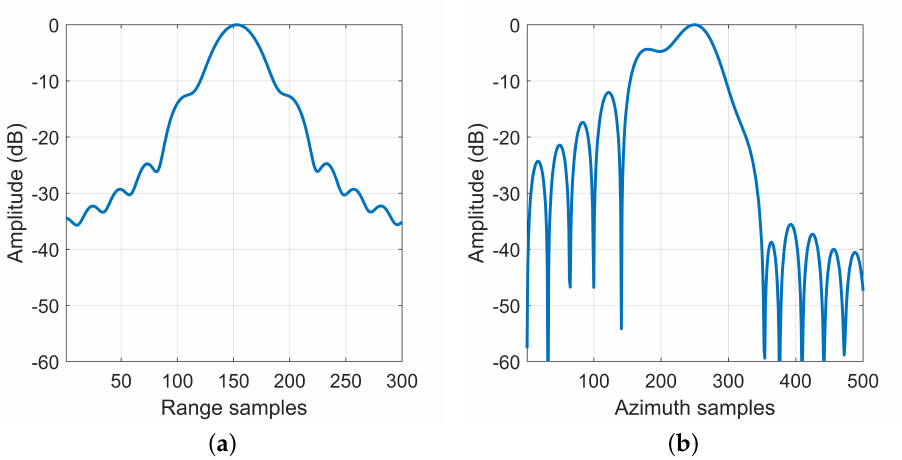
Figure 10. The profile of P 5 by using the start-stop model. ( a ) Range profile; ( b ) Azimuth